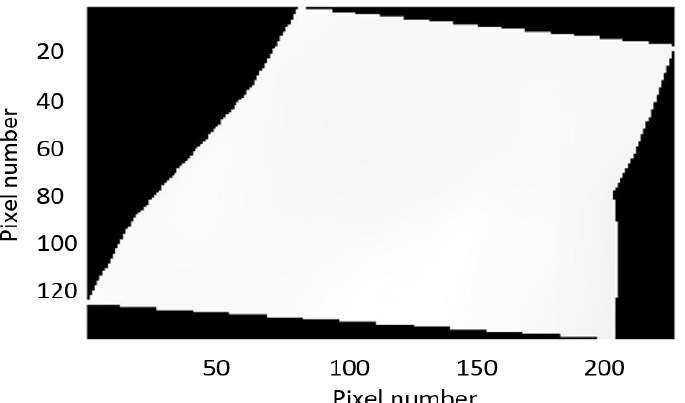
Figure 4. A typical averaged region of interest.